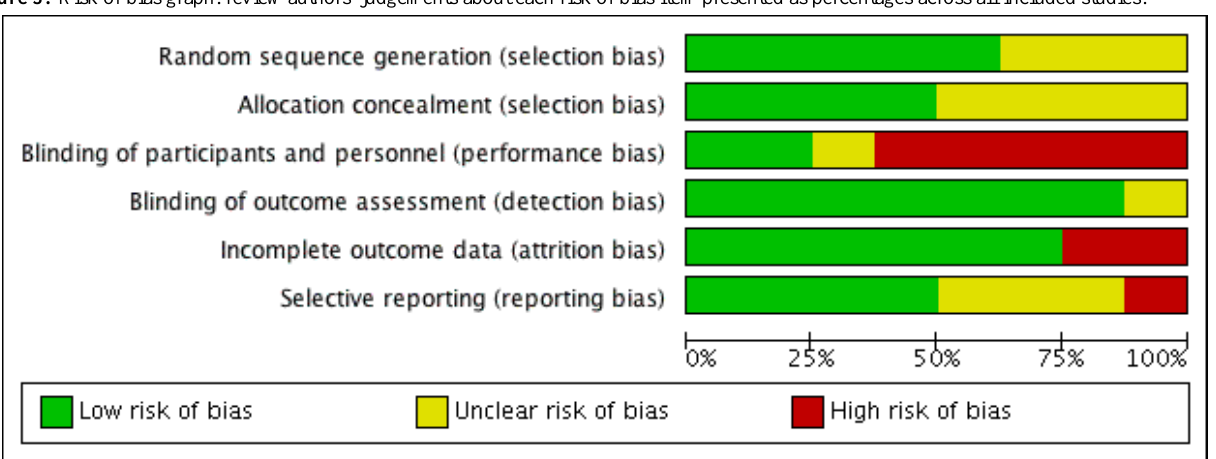
The cross-sectional (n=5) and other (n=6) studies assessed using the AXIS tool met, on average, 50% (range 26-80%) and 42% (range 29-70%) of the criteria, respectively [30].